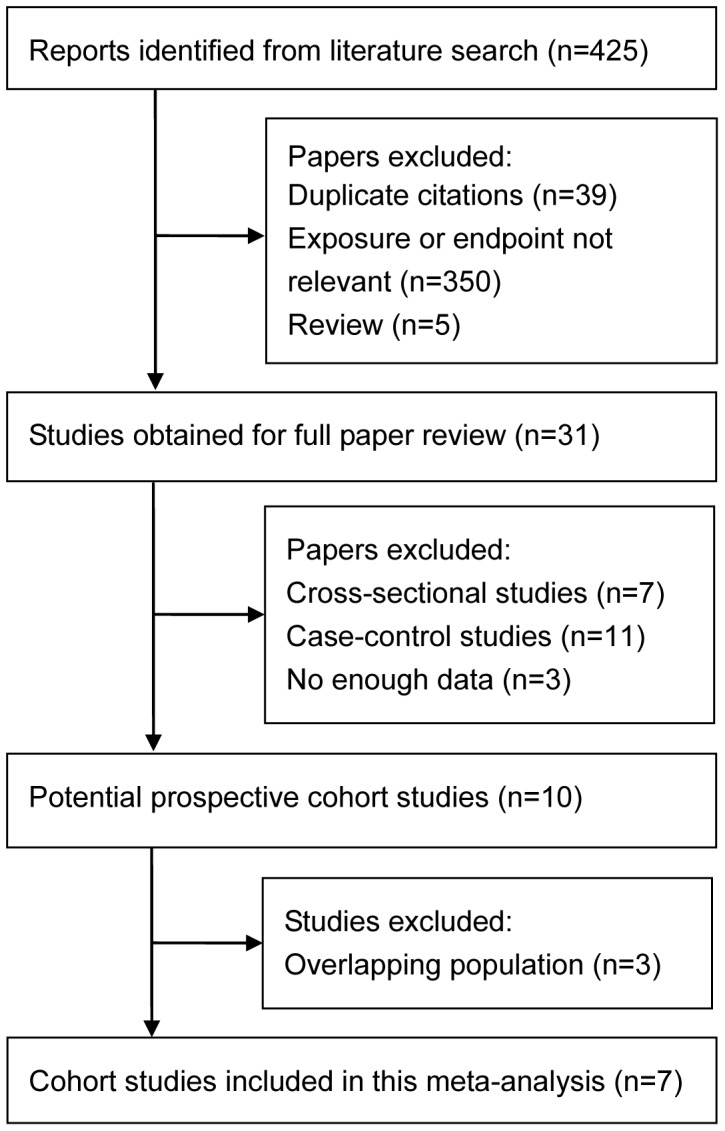
Flow chart of study selection.